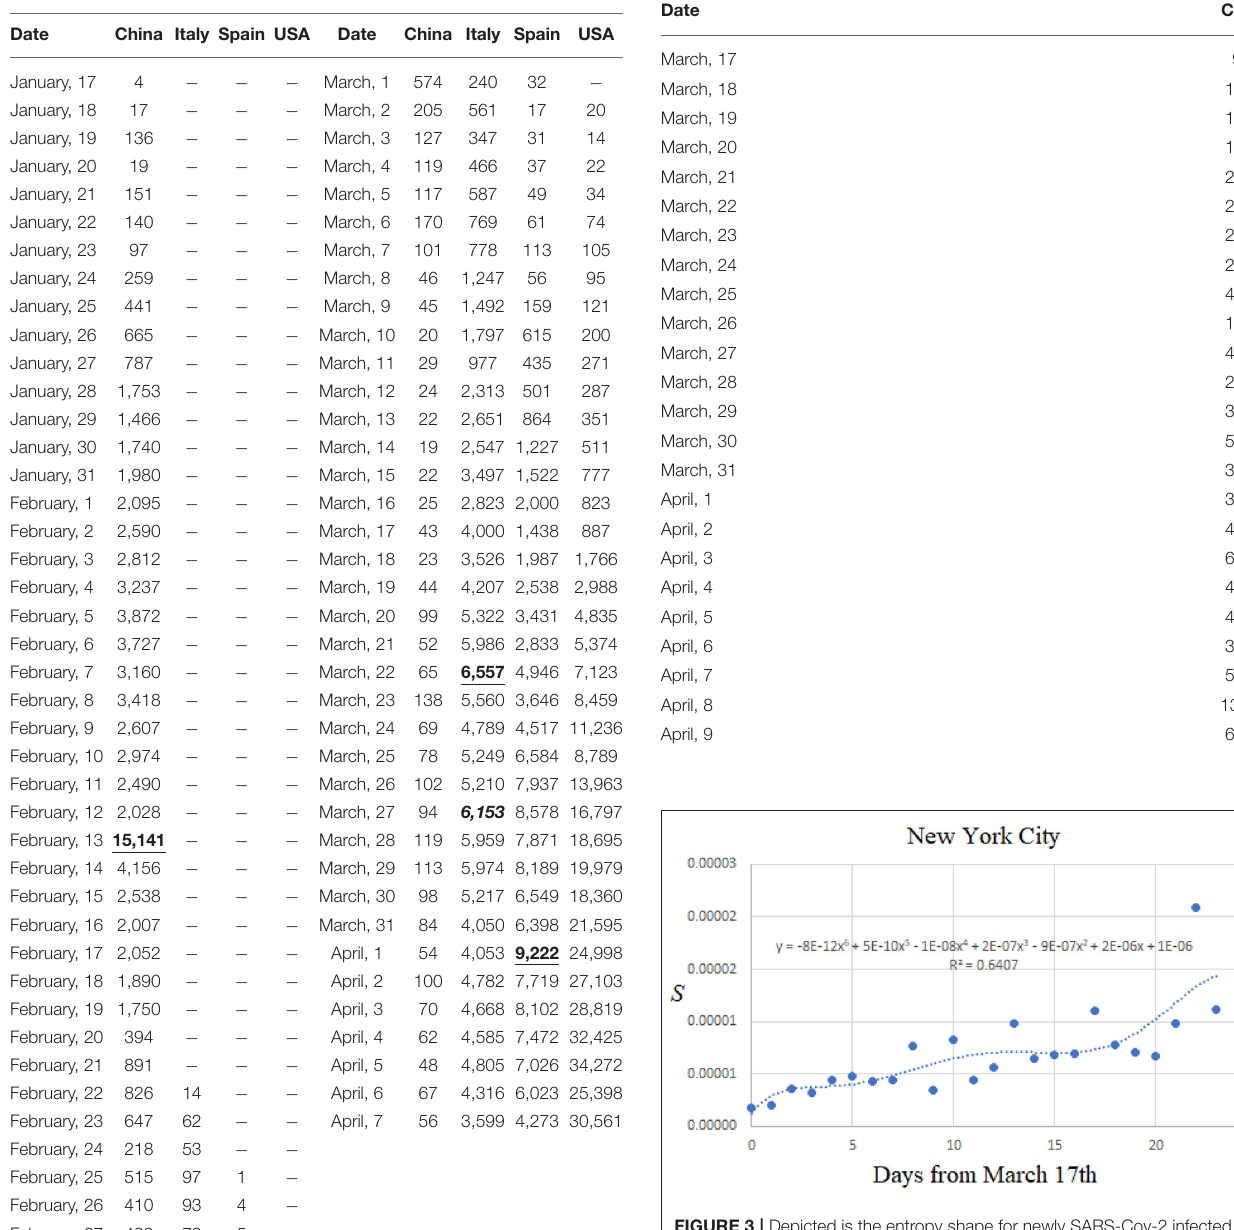
TABLE 2 | Data of SARS-Cov-2 infections for New York City, recoiled on https:// www1.nyc.gov/site/doh/covid/covid-19-data-archive.page (April 10th, 2020).